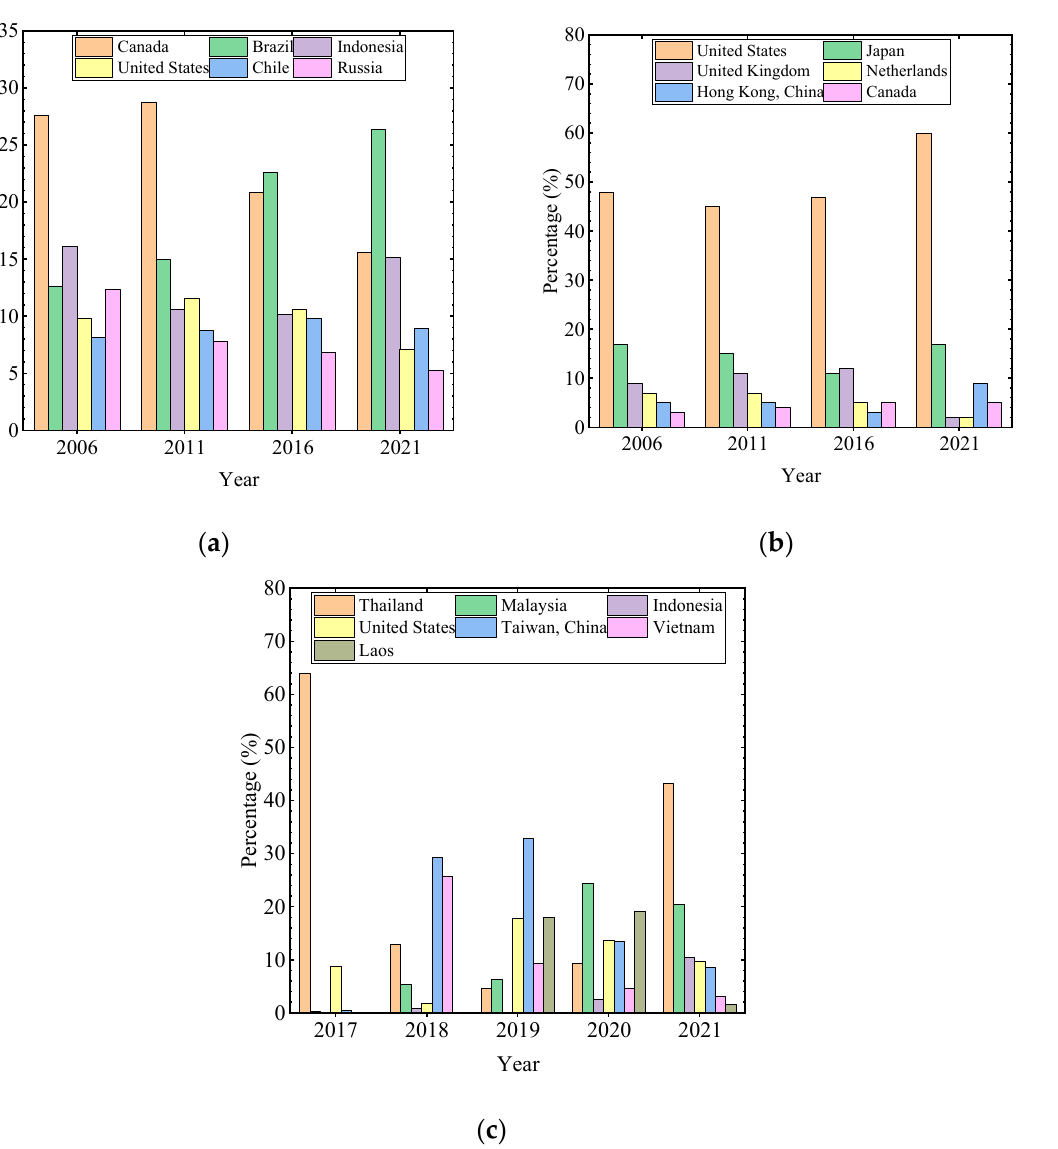
Figure 2. Percentage of major import trading partners of paper raw materials. ( a ) Wood pulp; ( b ) waste paper; ( c ) waste paper pulp.